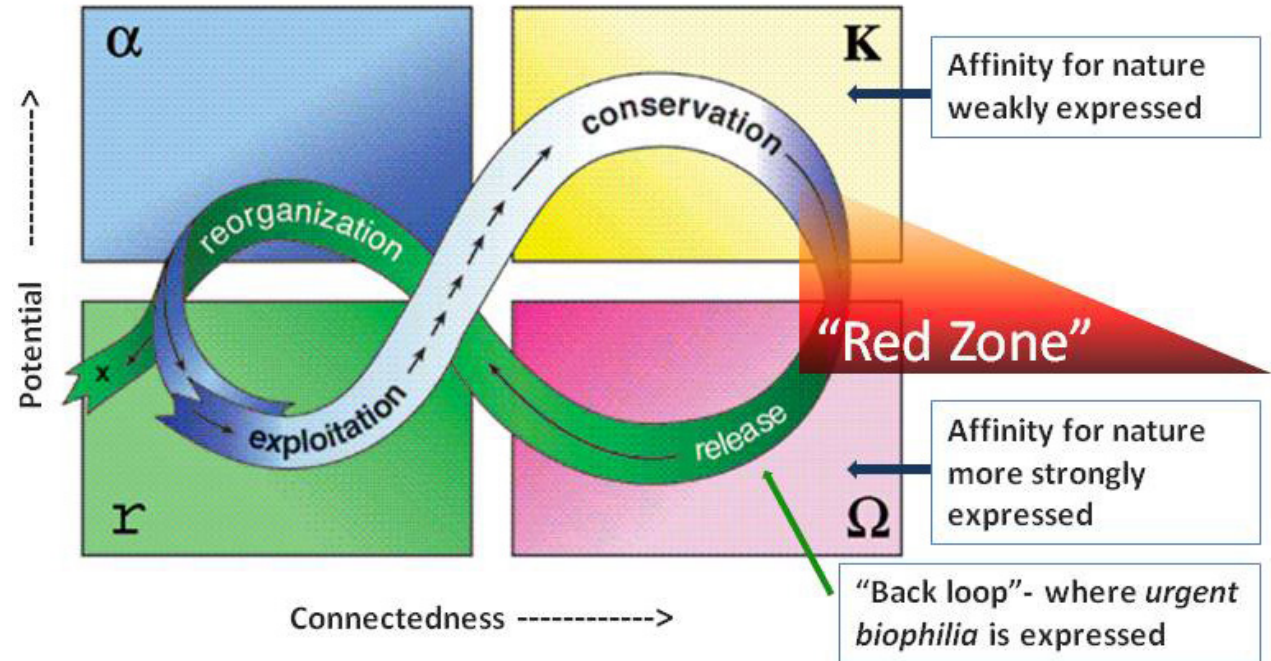
Fig. 1 . As adapted from Holling and Gunderson (2002) a stylized depiction of the four ecosystem functions ( r, K, w , a ) and the flow of events among them. Arrows show flow speed in the cycle; closely spaced arrows represent slow change and long arrows represent rapid change. The cycle reflects change in two properties (1) the Y axis is potential inherent in accumulated resources; (2) the X axis is the degree of connected among controlling variables. The transition from the K phase to the w phase is depicted here as ‘The Red Zone.’ Expression of biophilia or biological attraction is also represented, corresponding to the Y axis and potential. Low connectedness is associated with loosely connected elements whose behavior is dominated by external relations and variability. High connectedness is associated with elements whose behavior is dominated by internal relations that control or mediate external variability. The ‘back loop,’ in green, represents the stages during which urgent biophilia is likely expressed. The exit from the cycle at the left of the figure suggests the stage where the potential can leak away and where a ‘flip’ into a less organized and desirable system is likely. (Reproduced with permission of Island Press, Washington,